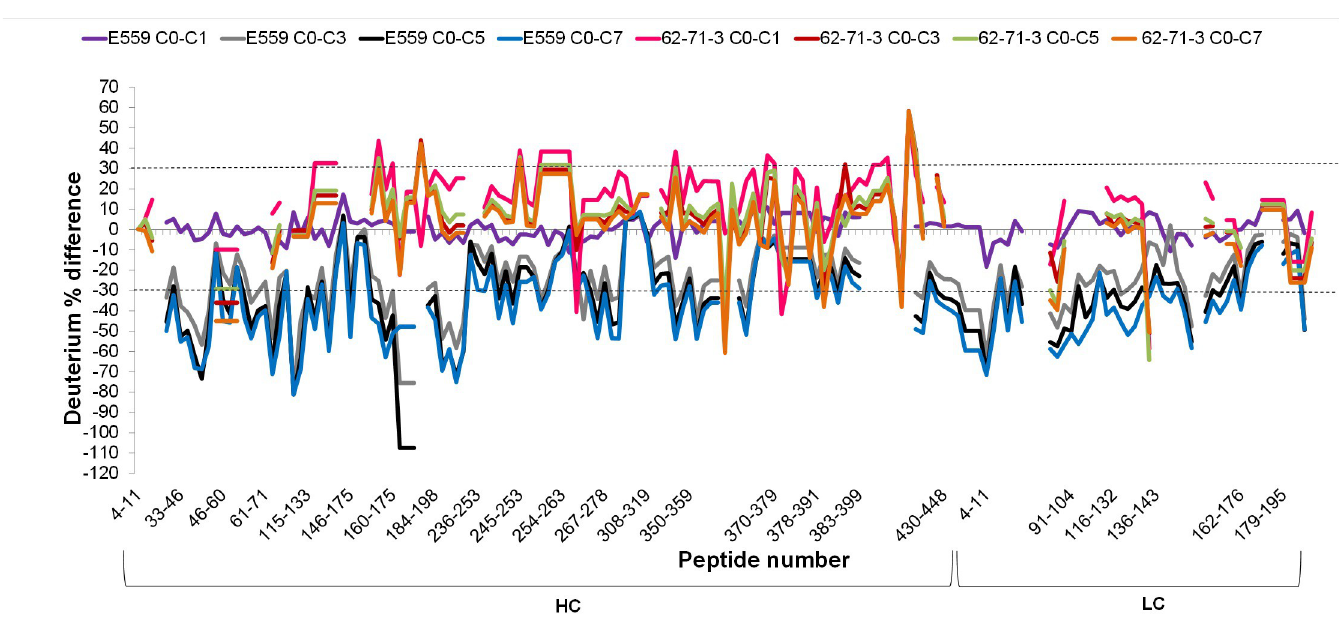
Fig 3. Difference in deuterium incorporation for peptides from E559 and 62-71-3 after F/T cycles 1, 3, 5 and 7. Structural perturbation due to freezing and thawing was monitored by subtracting the percent deuterium exchanged after 15 s on a non-frozen sample (C0) by the percent exchanged after F/T cycle 1, 3, 5 or 7.